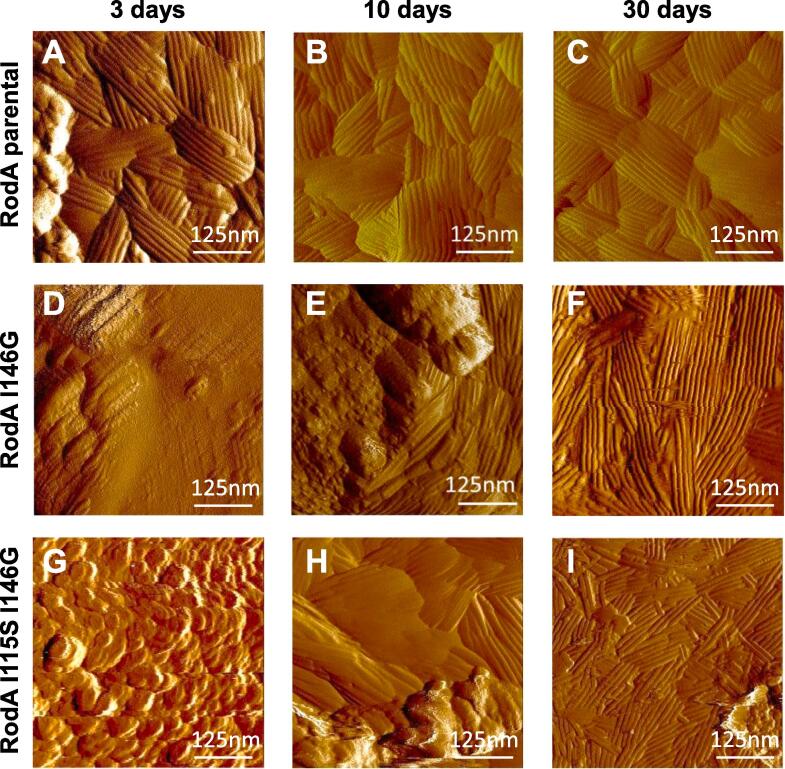
Delay in rodlets appearance on the surface of conidia imaged in liquid conditions. AFM deflection images of the rodlets layer for (A-C) the parental, (D-F) I146G and (G-I) I115S/I146G mutants after 3 (A, D, G), 10 (B, E, H) and 30 (C, F, I) days of growth.